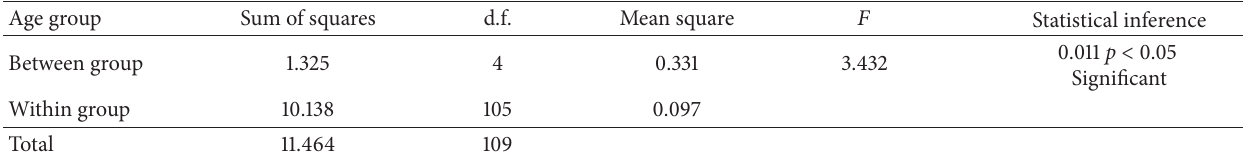
Table 7: ANOVA among age of the employees about the opinion of CRM strategy in Banking Industry in Madurai District. Age group Sum of squares d.f. Mean square 𝐹 Statistical inference Between group